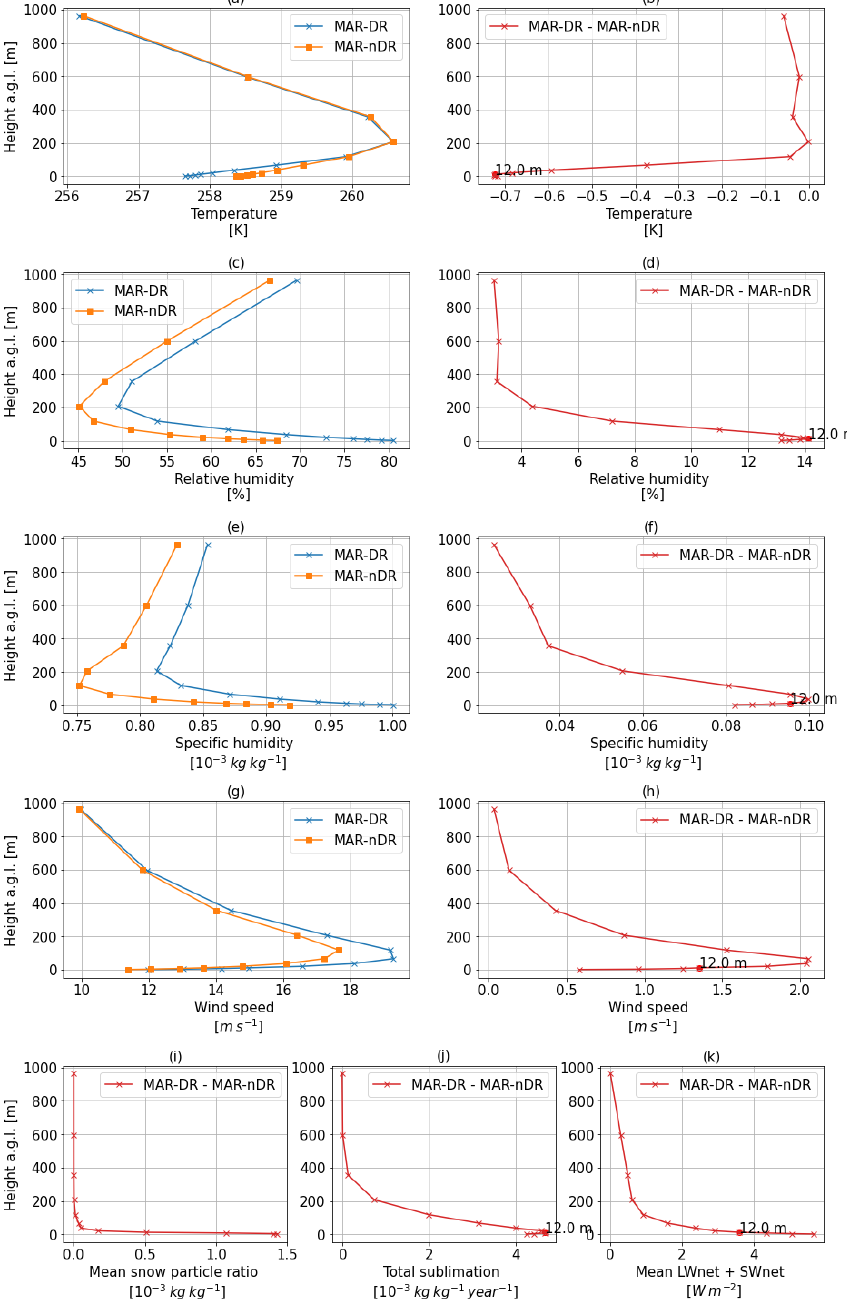
Figure 6. Annual mean (2010–2018) vertical profiles for near-surface and surface variables calculated at D17 on the lowest 12 vertical levels as simulated by MAR-DR, MAR-nDR, or the corresponding differences between both runs. In panel (i) , sublimation rates are expressed in grams of sublimated snow per kilogram of moist air per